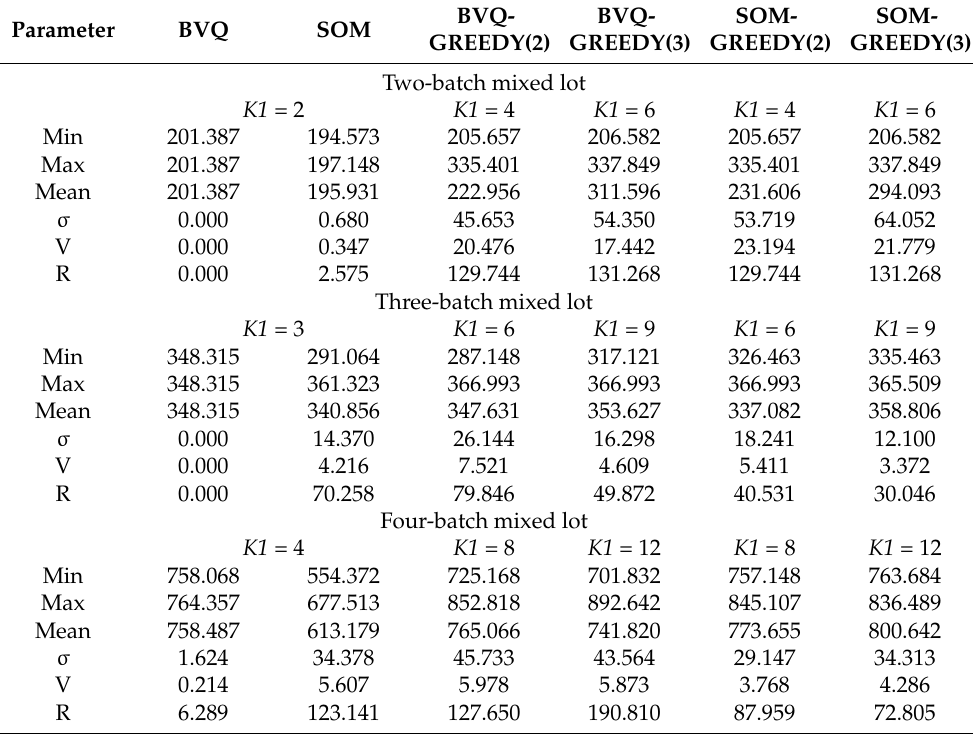
Table A11. Objective function value summarized after 30 attempts (Mahalanobis distance, initializa- tion by k-means).